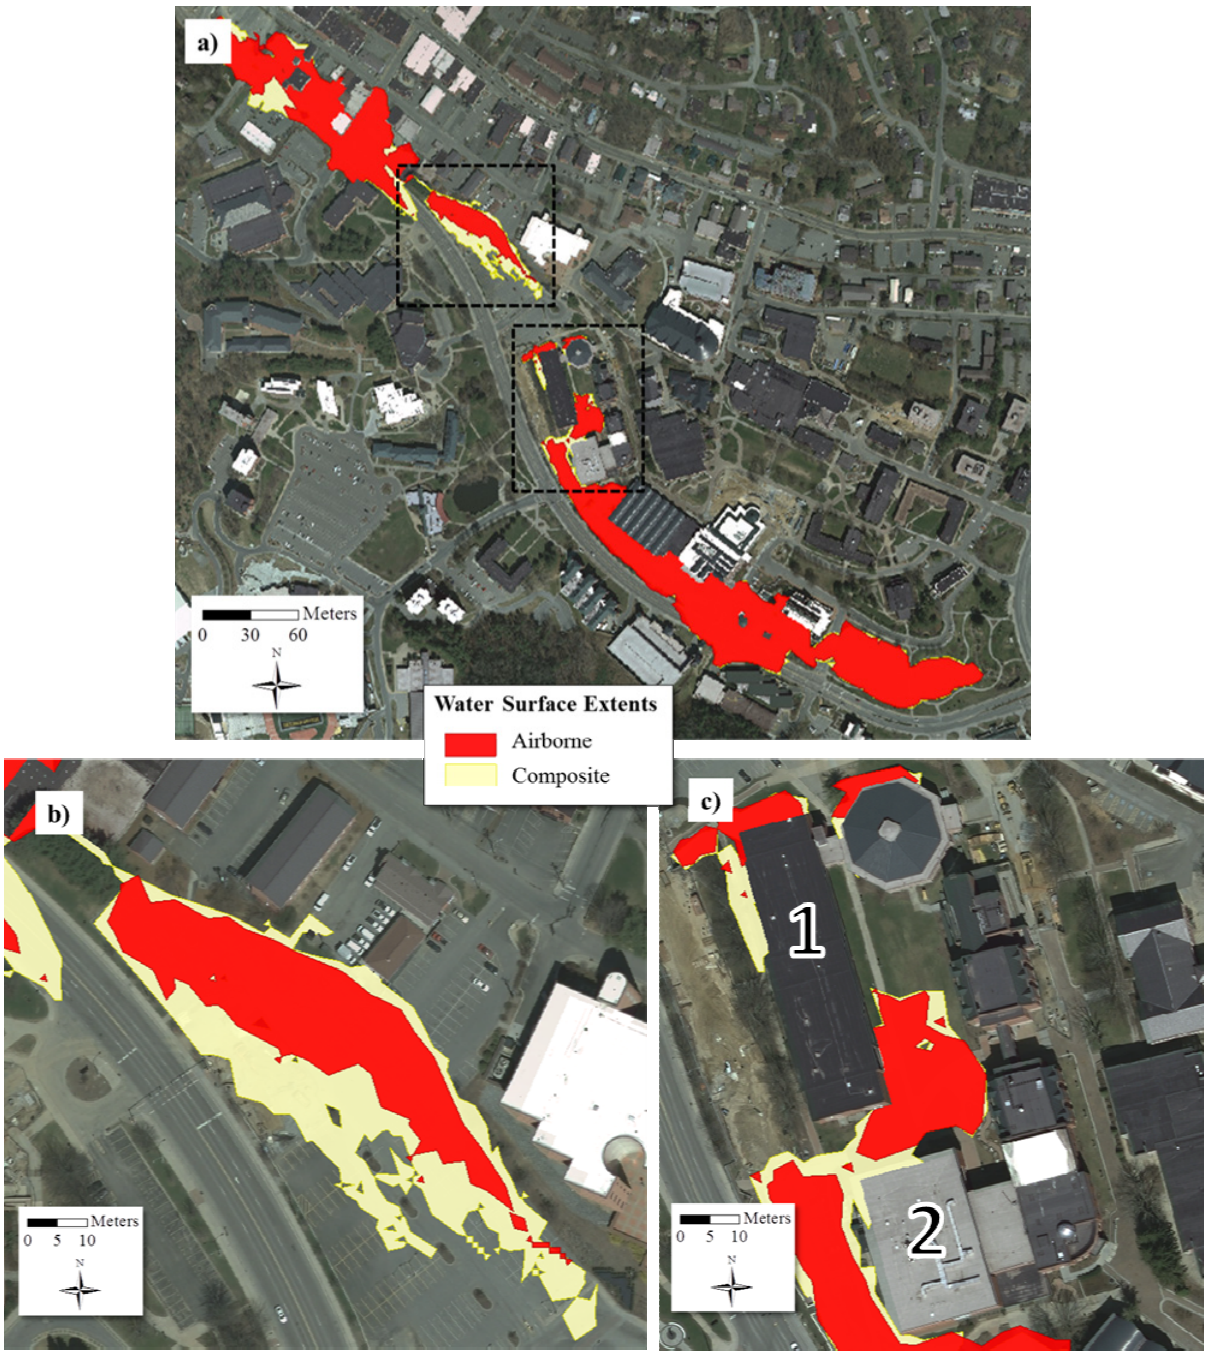
Figure 9. Water surface extents for the airborne (red) and composite (yellow) LiDAR datasets. ( a ) Study area. The dashed boxes represent the location of ( b ) and ( c ); ( b ) Expanded area indicated by the northern dashed box in the study area figure; ( c ) Expanded area indicated by the southern dashed box in the study area